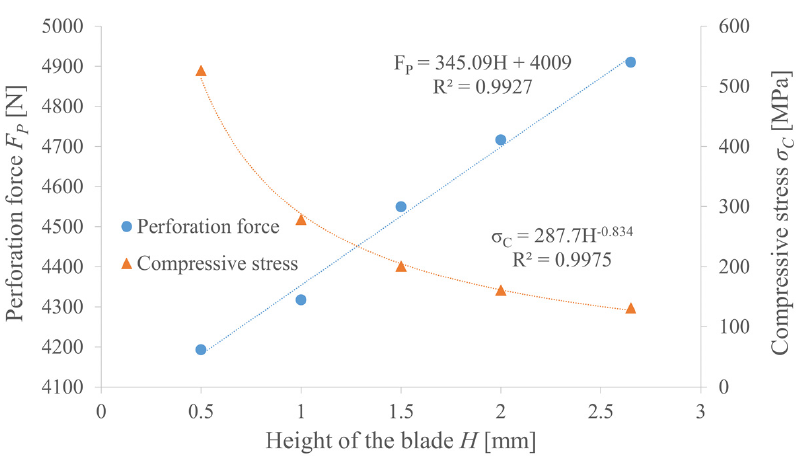
Figure 23. The influence of the height of the blade H on the perforation force F P and the punch compressive stress σ C for PI punch with diameter d = 10 mm and effective angle of the blade β = 27.5° mm for belt TFL10S (markers represent simulation results, lines represent approximations of functions F P ( H ) and σ C ( H )).